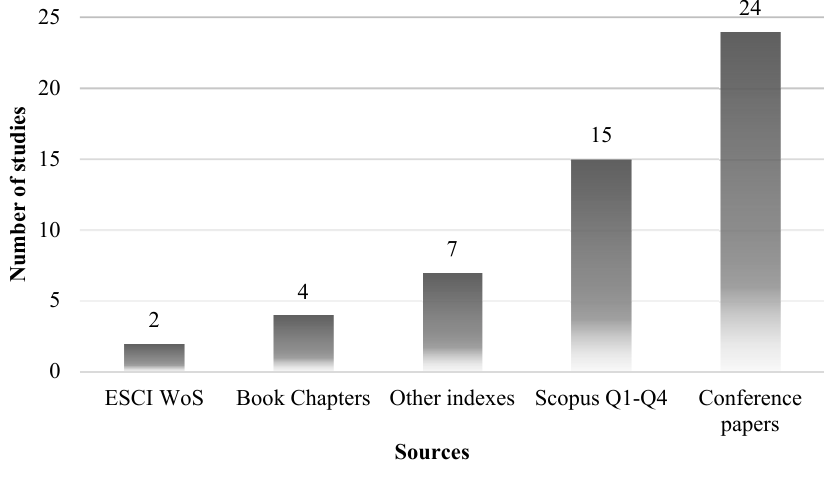
Figure 5. Sample Figure 5. Sample composition. Figure 5. Sample composition.